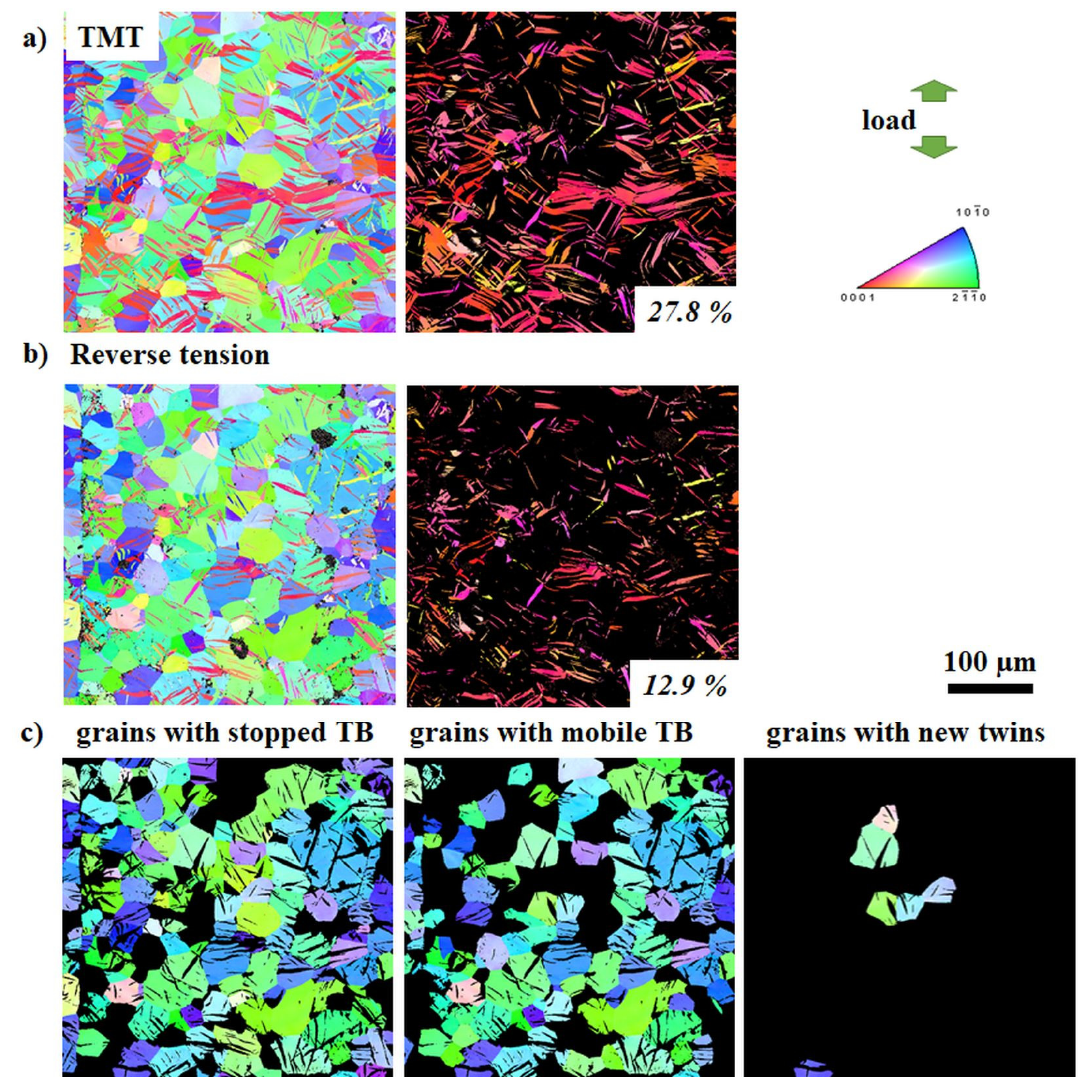
Figure 8. Orientation maps (entire microstructure and twins only) of the ZN10 alloy in the TMT state ( a ) and subsequent loading in tension up to 2% of strain ( b ). Orientation maps for grain grouping for reverse tensioned samples with respect to TB mobility ( c ). Color code for orientation maps represents orientation with respect to ED.